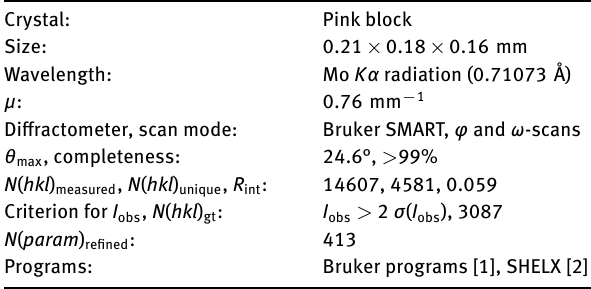
Table 1: Data collection and